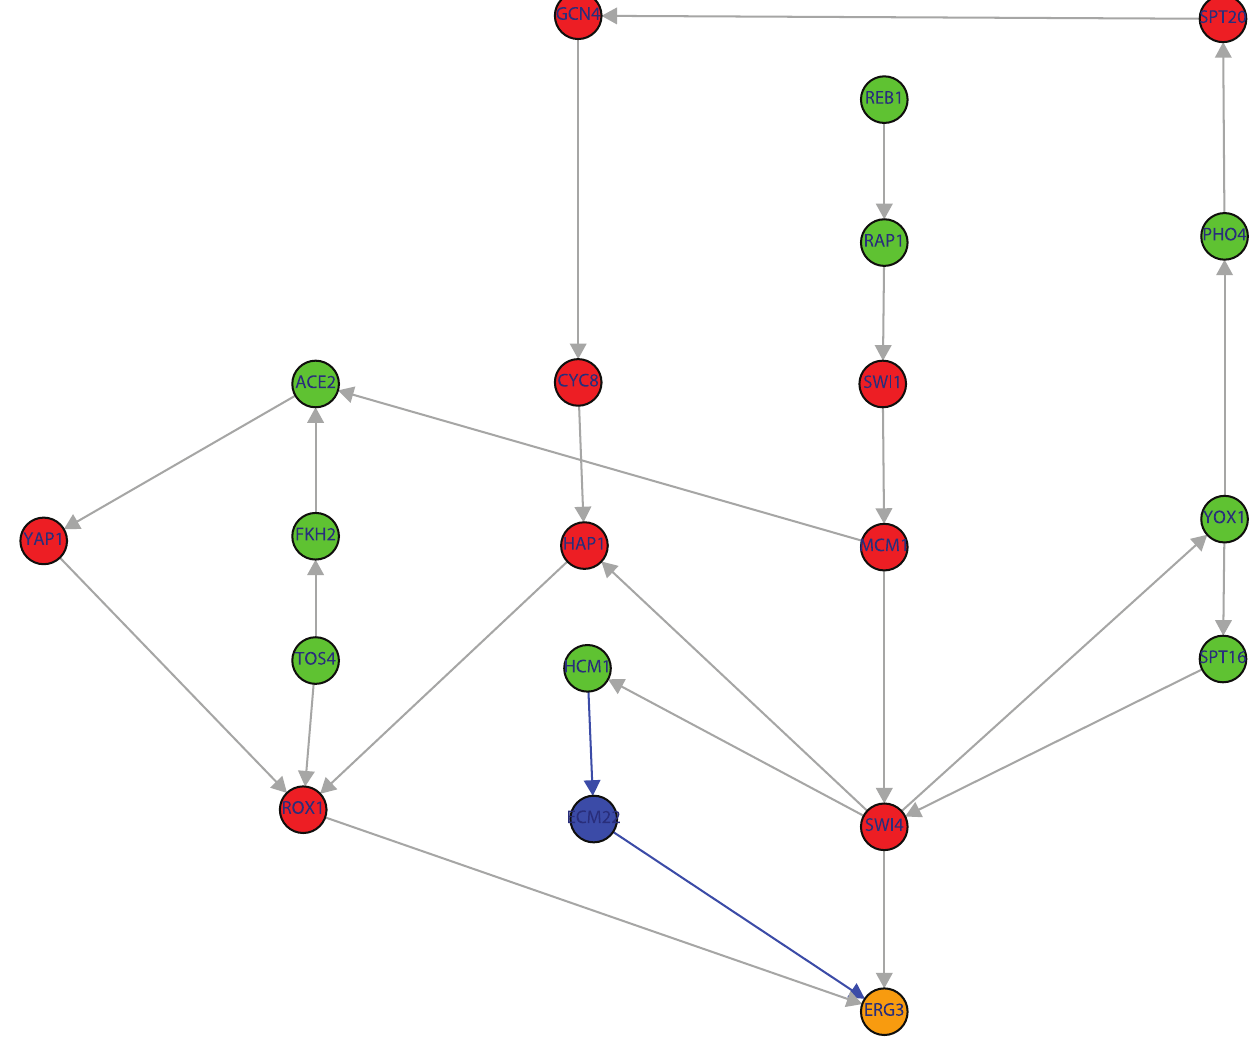
Figure 5. Subnetwork of the TRN consisting of 20 genes (color code as in Fig. 1). The shown subnetwork complements the results in table 1 by providing detailed information about the genes involved in the shortest paths. Blue edges indicate the shortest path connecting HCM1 R ECM22 R ERG3.